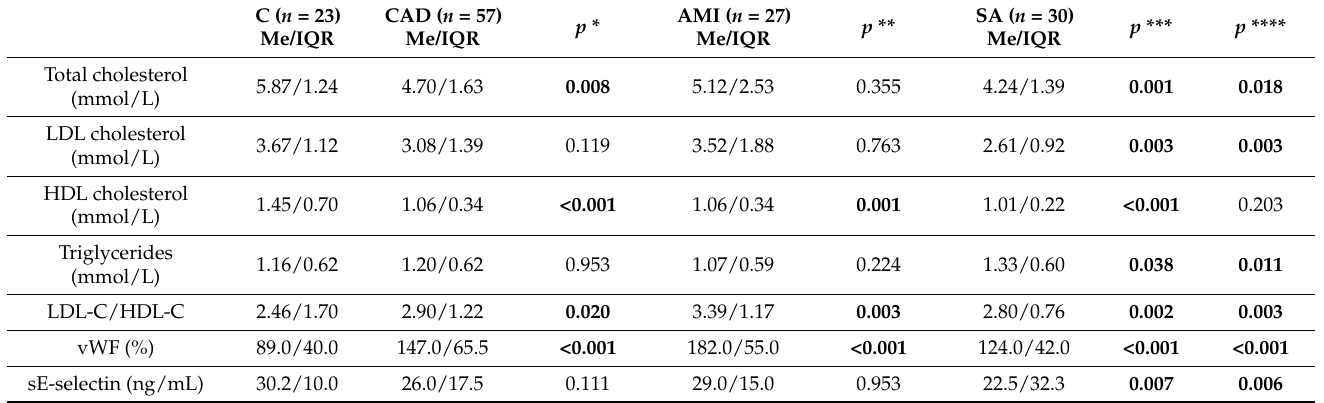
Table 2. Lipid parameters and endothelial cell markers in the control (C) subjects without cardiac symptoms and in the coronary artery disease (CAD) patients, divided into two subgroups, including acute myocardial infarction (AMI) and stable angina (SA)